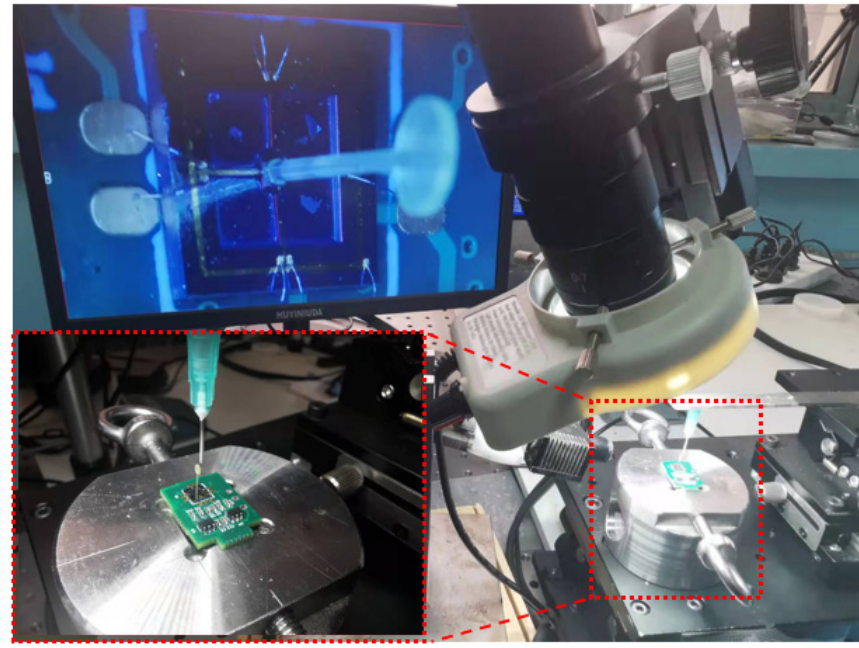
Figure 9. Secondary integration of sensor microstructure.